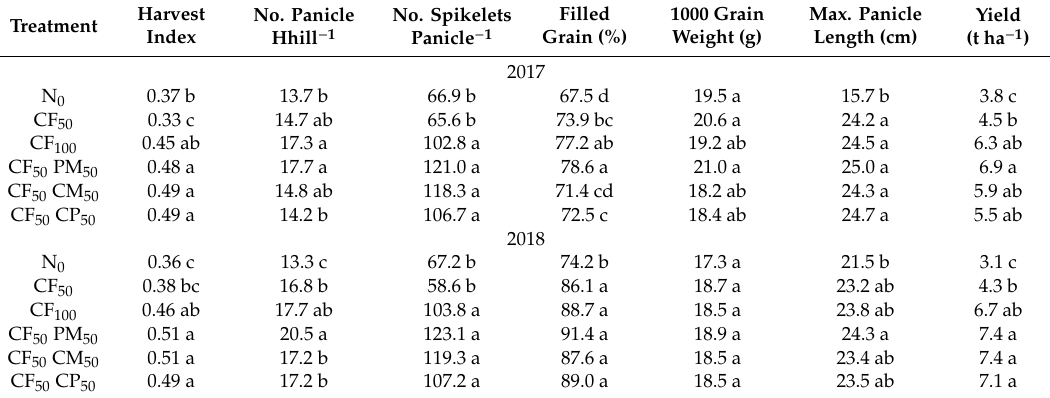
Table 5. Harvest index, yield and yield attributes of rice variety Manawthukha a ff ected by organic